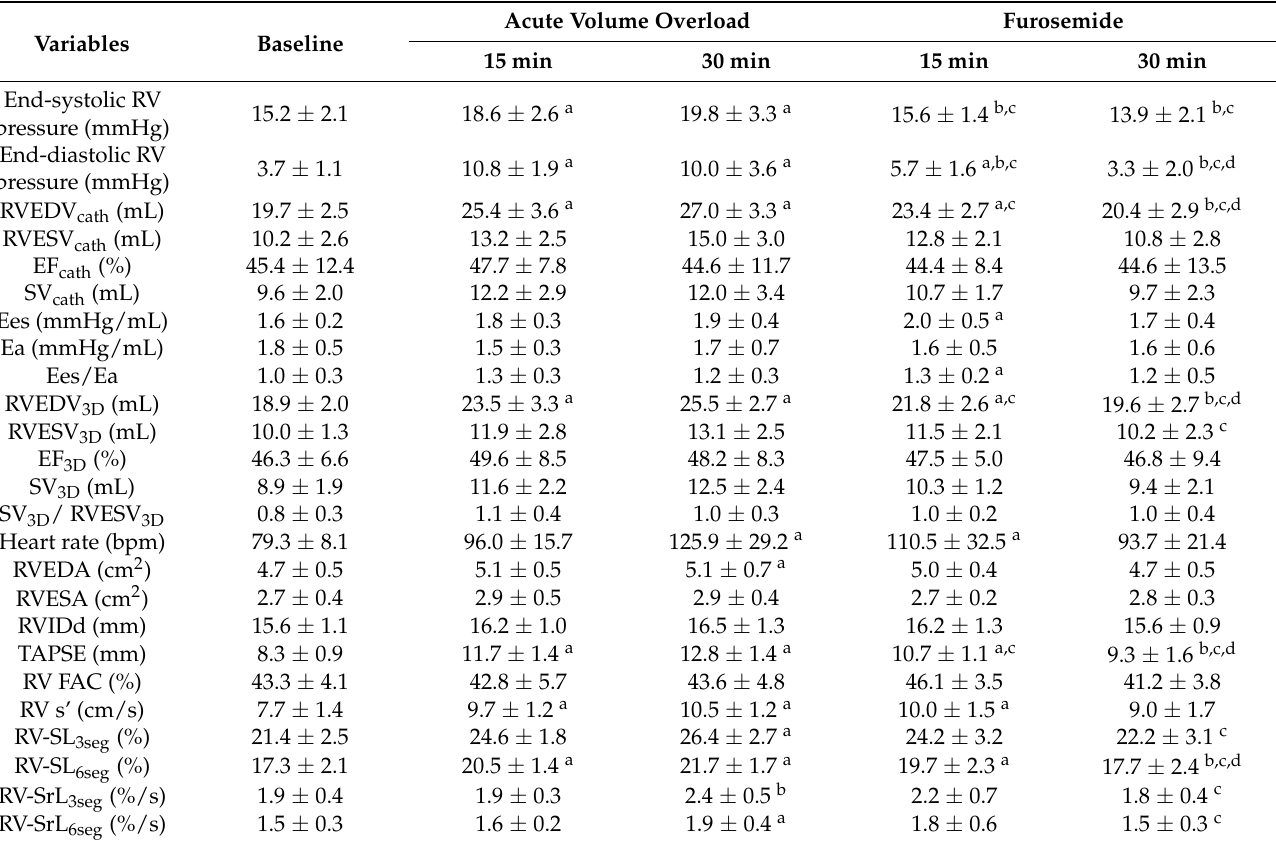
Table 2. Results of the right ventricular morphology and functional variables obtained by right heart catheterization, real-time three-dimensional echocardiography, and two-dimensional echocardiogra- phy with acute changes in volume loading